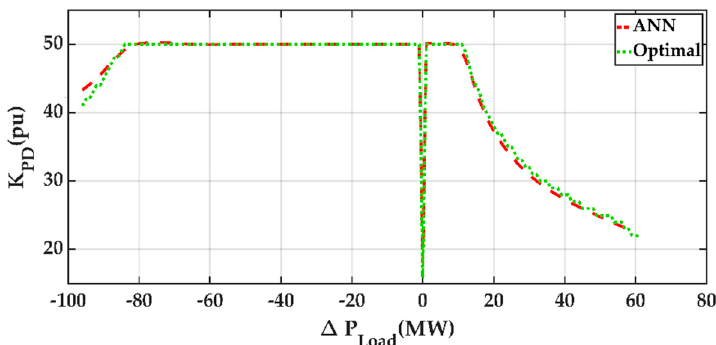
Figure 15. Droop gain K PD from the ANN-based controller and optimal controller ( V W = 10.5 m/s and wind penetration = 29.4%).